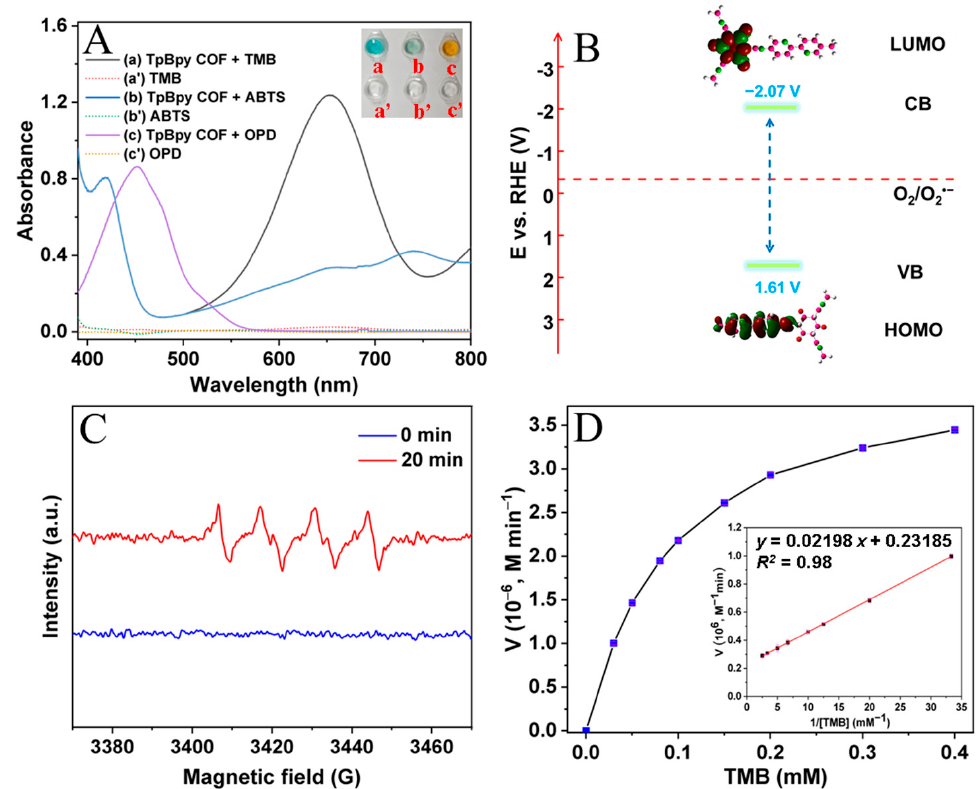
(Table 2), the K m value of TpBpy COF was lower, suggesting the stronger affinity of TpBpy COF toward TMB than other oxidase-like catalysts.